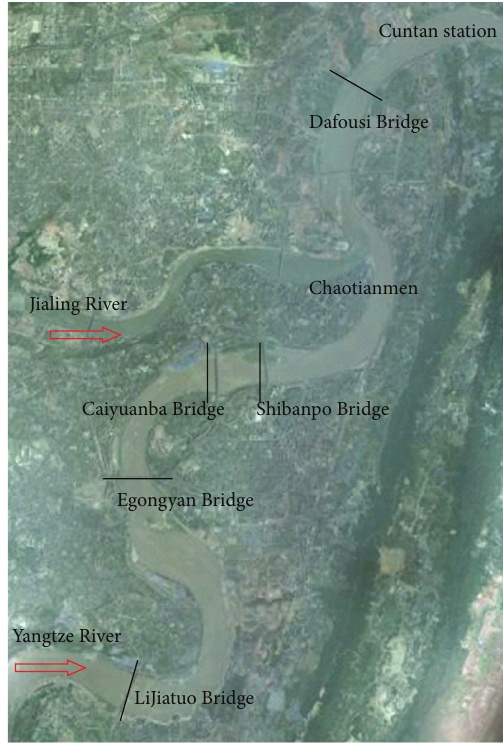
Figure 1: The plan of Chongqing city of Yangtze